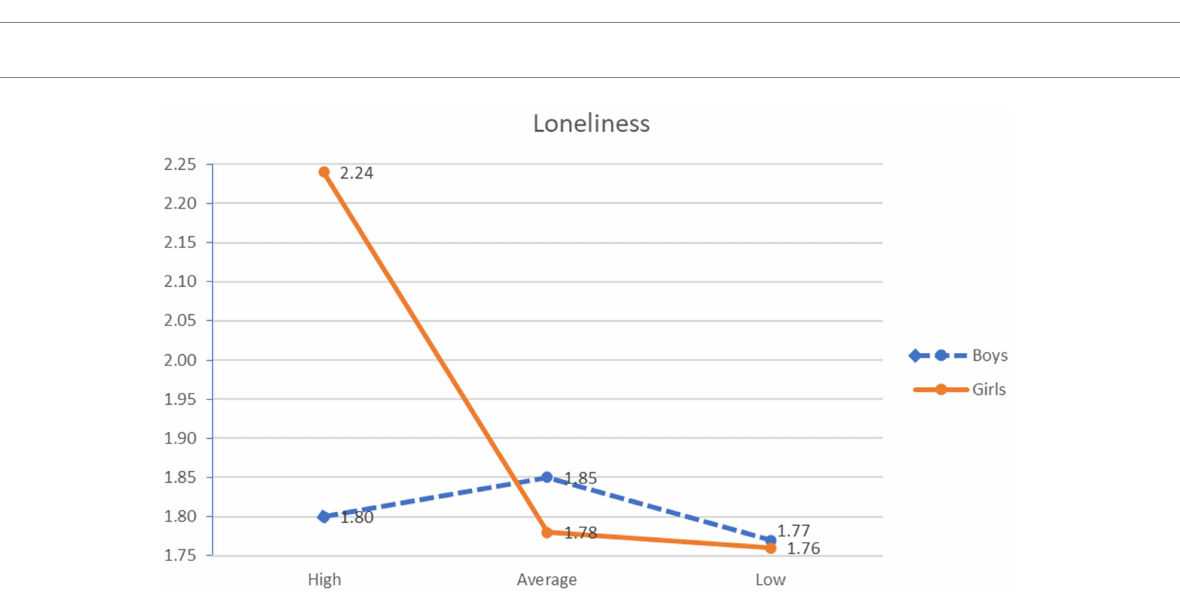
FIGURE 2 Interaction effect feeling of guilt × gender and